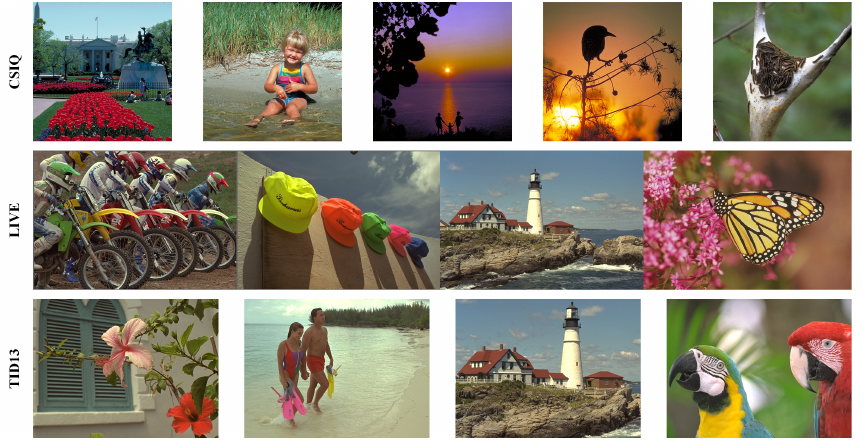
Figure 1. Several representative pristine images in the three datasets. In the three databases, Gaussian blurring is synthesized intentionally. To each pristine image, its R, G, and B channels are filtered using a circular-symmetric 2-D Gaussian kernel of standard deviation ( δ ) of Gaussian distribution [57], as shown in Equation (1), where c is a color channel, δ stands for the standard deviation of the distribution, x and y are the location indices of pixels. The three color components of an image are blurred using a same kernel, while, to different images, the values of δ change in different